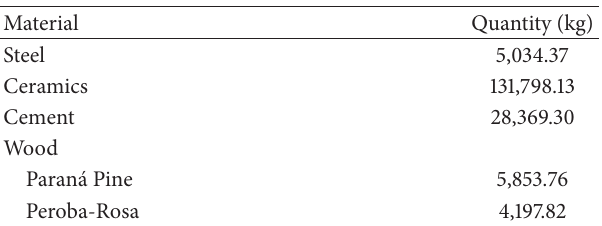
Table 1: Quantities of materials [22].